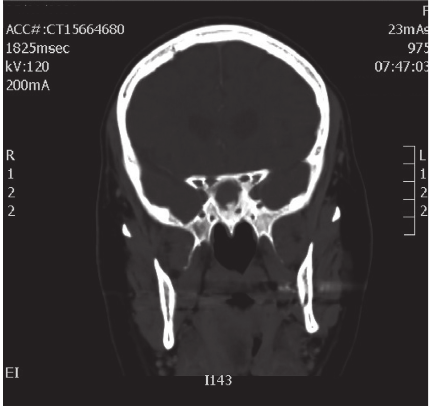
Figure 10: Coronal CTscan sinuses showing a sphenoid opacity of fungal ball post endonasal endoscopic pituitary surgery.